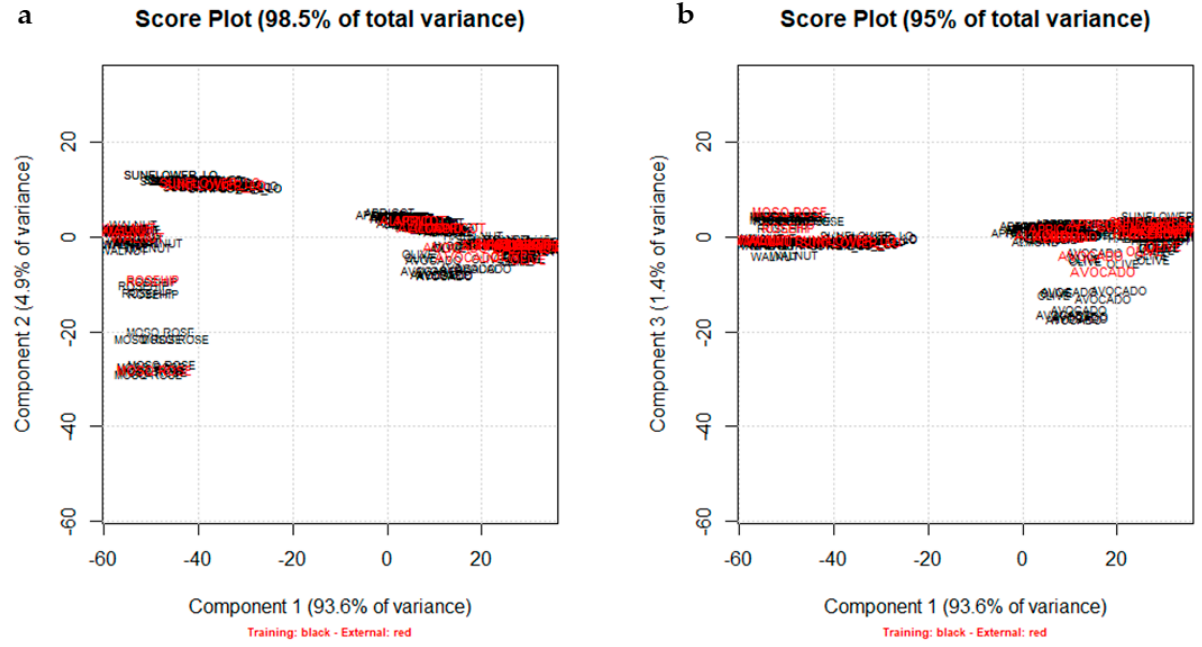
Figure 3. The projection of the external test set (B 27,18 : red ink) on PC1–PC2 ( a ) and PC1–PC3 ( b ) score plots, respectively.